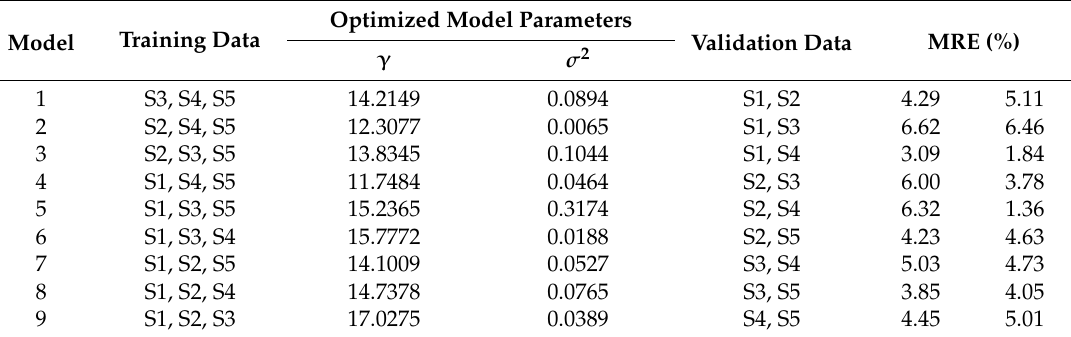
Table 10. The optimized parameters for different training data and the prediction results.